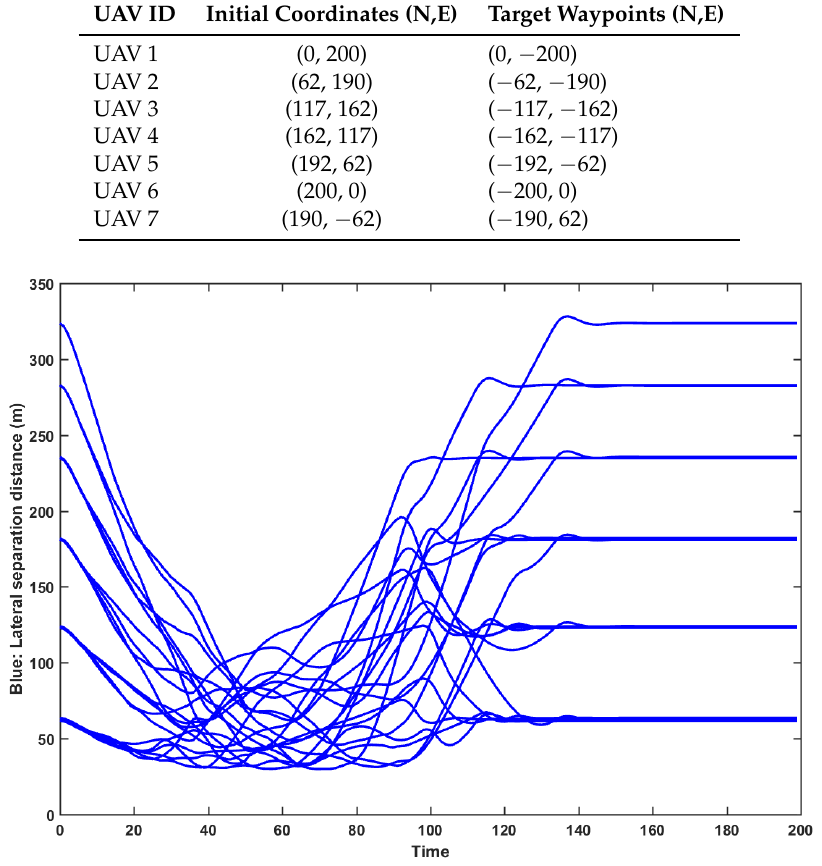
Figure 21. Case 4: Seven UAV control (horizontal separation distance